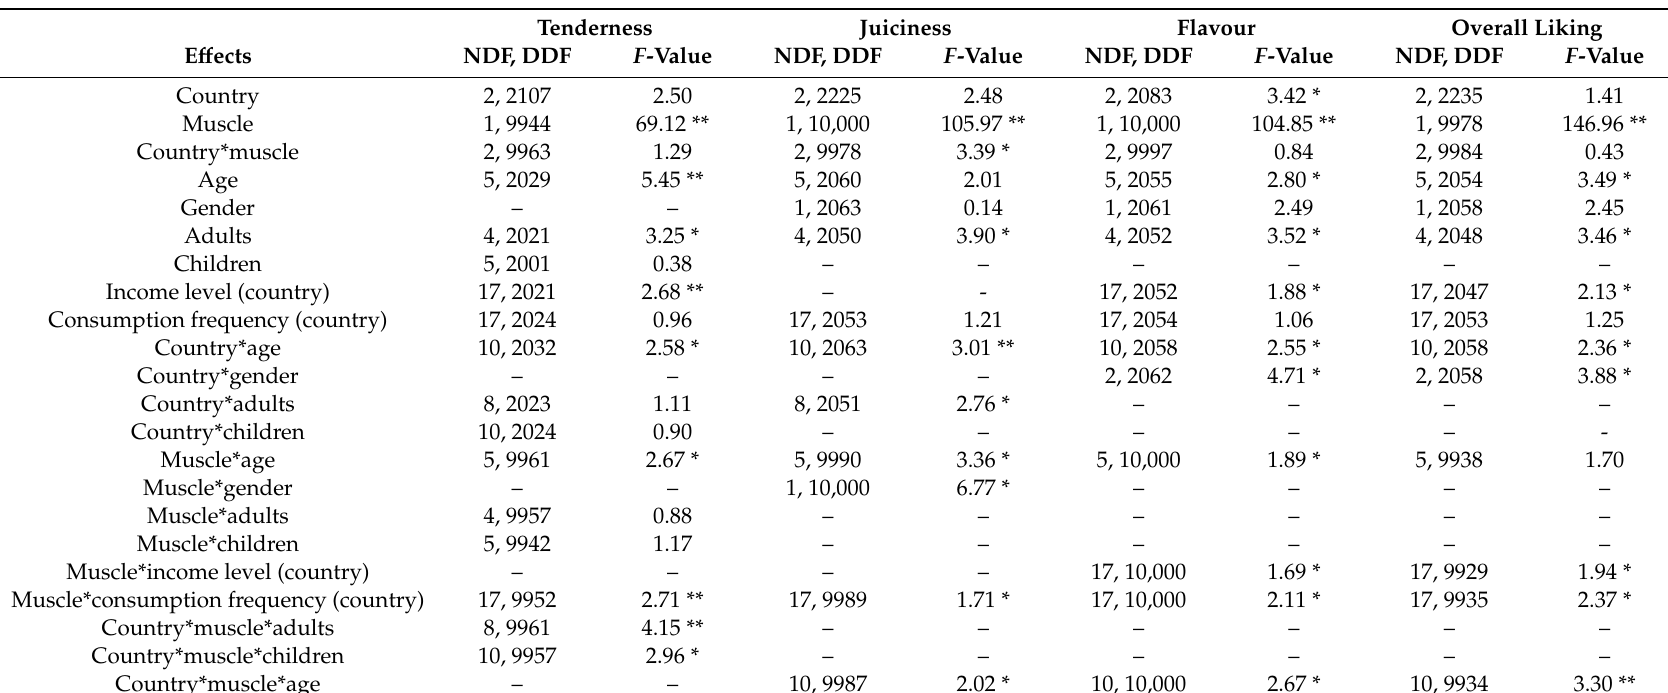
Table 2. F -values, numerator and denominator degrees of freedom (NDF and DDF) for base linear mixed e ff ects models for predicted eating quality scores of tenderness, and juiciness, liking of flavour and overall